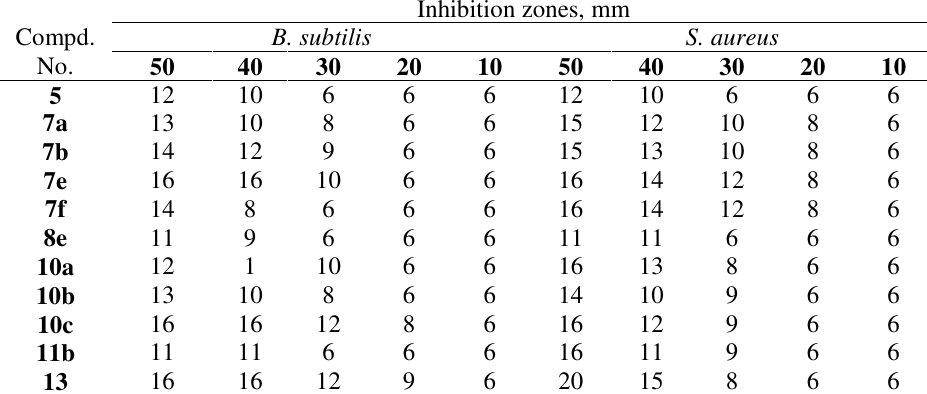
Table 2. MIC of the biological active compounds towards the Gram -positive bacteria*: Inhibition zones, mm B. subtilis S. aureus Compd.